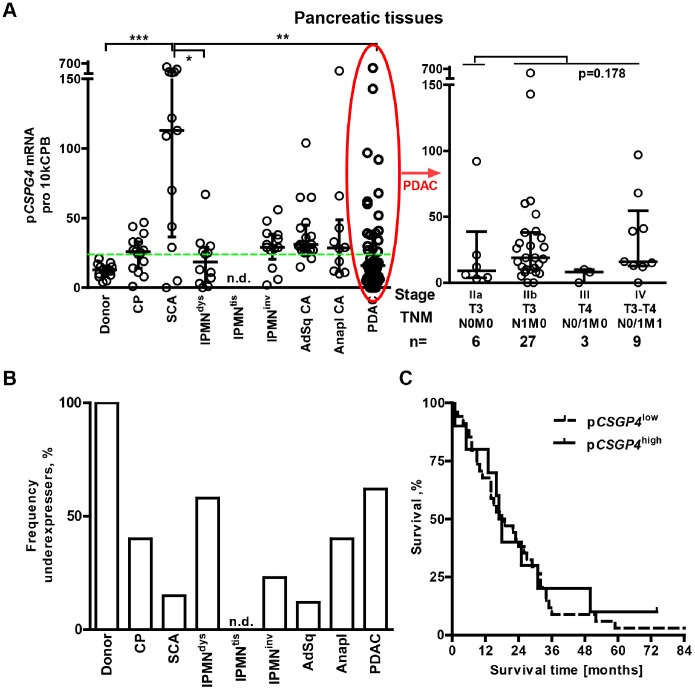
Maintenance of pCSPG4 mRNA expression in pancreatic tissues.(A) The pCSPG4 copy number was measured using qRT-PCR in pancreatic tissues (n = 139) and normalized to that of the housekeeping gene cyclophilin B (CPB). It is presented as the amount of transcripts per 10 kCPB copies. An elevated pCSPG4 mRNA level was observed in all groups compared to donors (p-values <0.01; Mann-Whitney tests), except IPMNdys (p = 0.47) and PDAC (n = 0.20). Kruskal-Wallis and Dunn’s test analysis, comparing multiple groups within the entire cohort, established an overexpression of pCSPG4 in serous cystadenoma, SCA (*p<0.05, **p<0.01 and ***p<0.001 significance level). The dotted green line represents the median level used to estimate the frequency of the underexpressers in the panel (B). (C) Kaplan-Meier survival curves for pCSPG4
low and pCSPG4
high (upper quartile; over 38 copies/10 kCPB) groups.